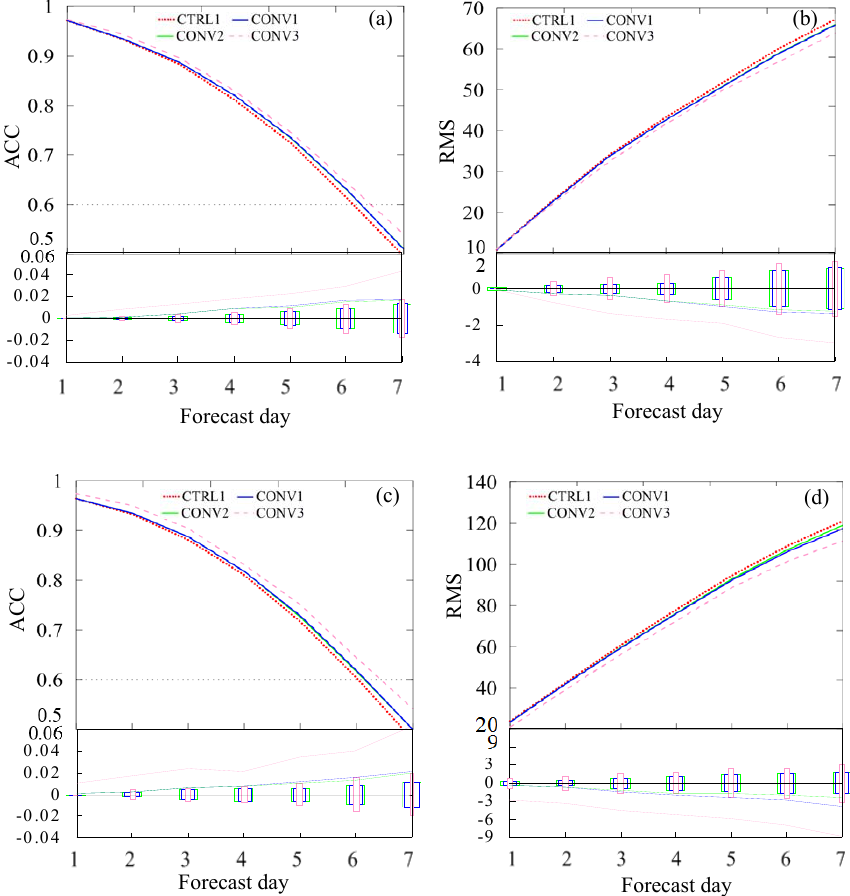
Figure 18. Mean ACC (left panels) and RMS (right panels) of 500hPa geopotential height of CTRL1 (red dashed line), CONV1 (blue solid line), CONV2 (green solid line) and CONV3 (pink dashed line) experiments in (a–b) the Northern Hemisphere and (c–d) the Southern Hemisphere for the period from 1 to 27 July 2014. The statistical significance testing of CONV1 and CTRL1, CONV2 and CTRL1, CONV3, and CTRL1 are shown in the lower part of each figure in blue, green, and pink. The ACC and RMS differences outside of outline bars are significant at the 95% confidence